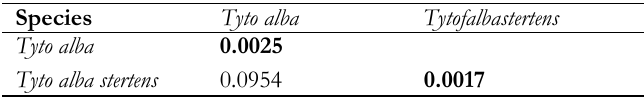
T ABLE 3- Kimura-2-parameter genetic distance interspecies and intraspecies (Bold numbers) in mitochondrial CYTB gene for T. alba and T. a. stetens